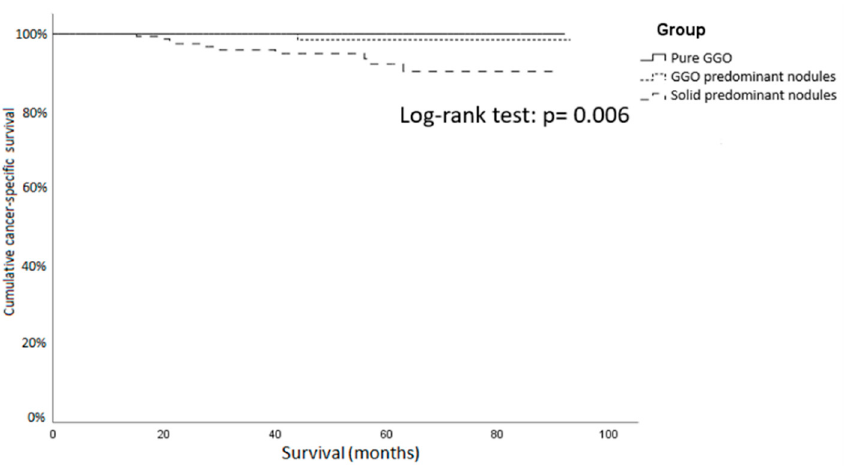
Figure 3. Cancer-specific survival curve of GGO patients with lobectomy or bilobectomy. The pure GGO group and GGO predominant group showed a significantly longer cancer-specific survival than the solid predominant GGO. GGO: ground-glass opacity.